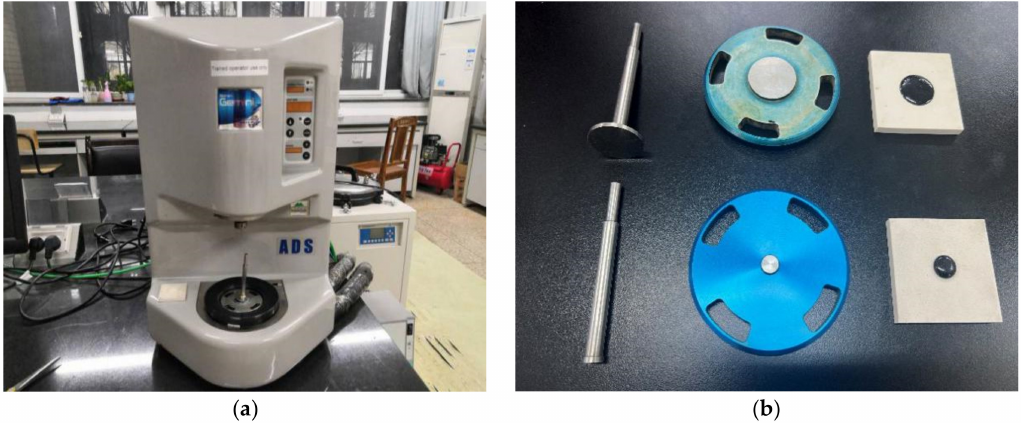
Figure 1. ( a ) Dynamic shear rheometer; ( b ) DSR parallel plate and asphalt test